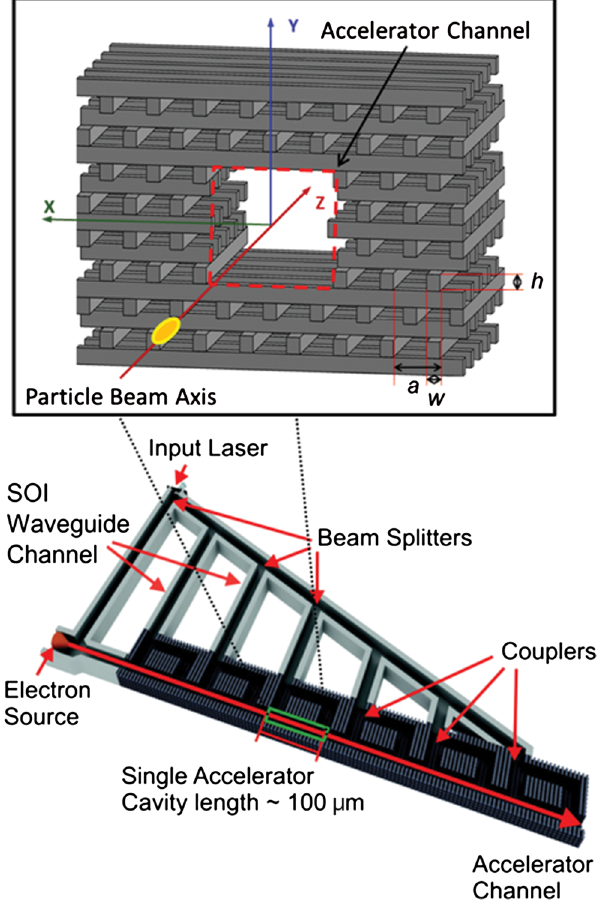
FIG. 1. Conceptual schematic of an on-chip woodpile accel- erator consisting of multiple accelerator cavities. Inset: layout of a woodpile accelerator waveguide section supporting speed-of-light accelerating mode. Individual silicon rod ’ s width, height, and spacing within each horizontal layer are denoted as w , h , and a ,